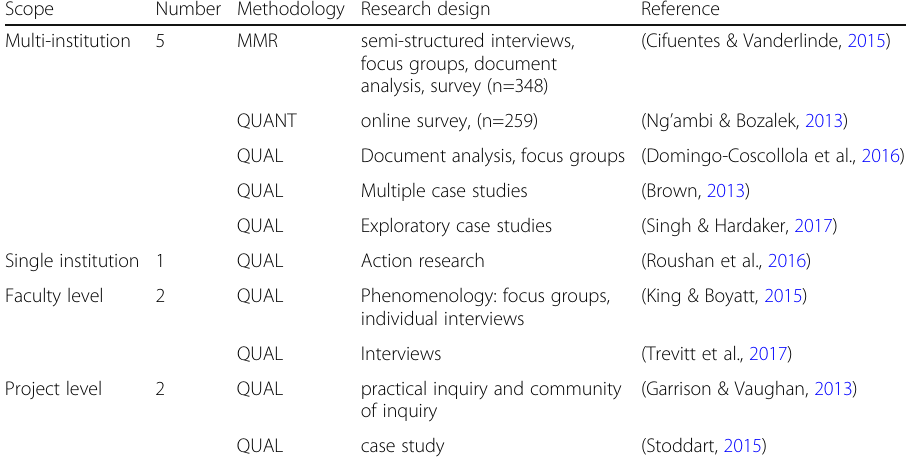
Table 6 methodologies and research design by population scope (holistic studies)